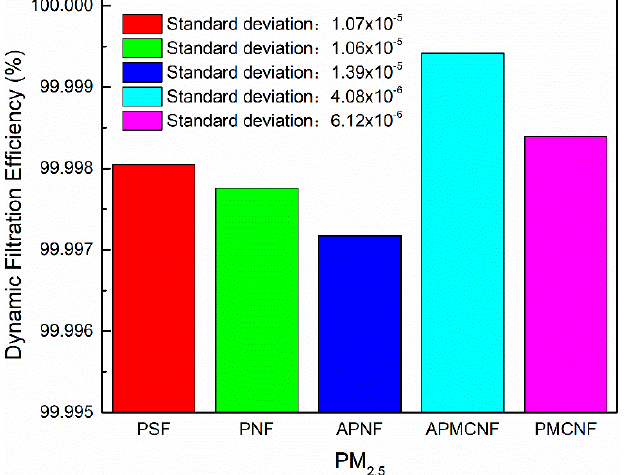
Figure 15. The dynamic filtration efficiencies of the five filter media for PM 2.5 during the performance test period.